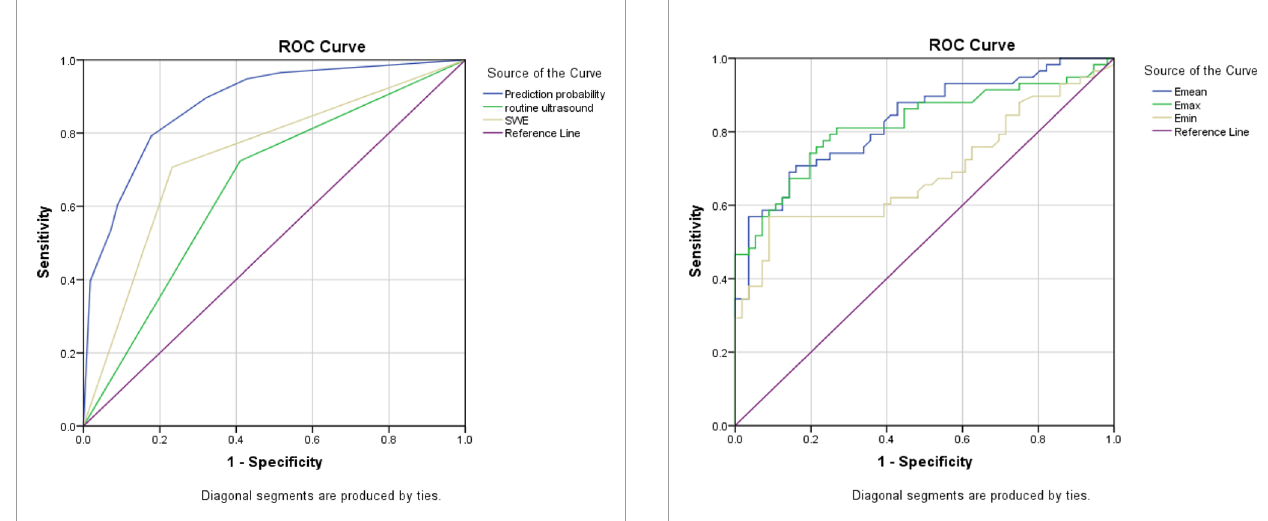
FIGURE 2 | Three ROC curves for the sensitivity and speci fi city of the Emean, Emax, and Emin in the application of ANM